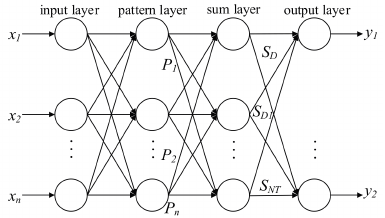
Figure 1. Structure of the generalized regression neural network